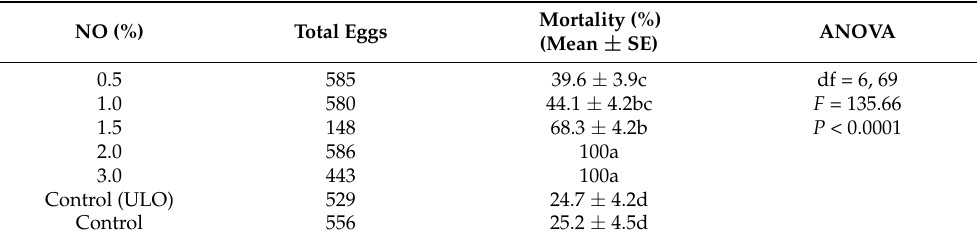
Table 2. Responses of codling moth eggs to 24 h nitric oxide fumigation treatments at different concentrations at 2 ◦ C.